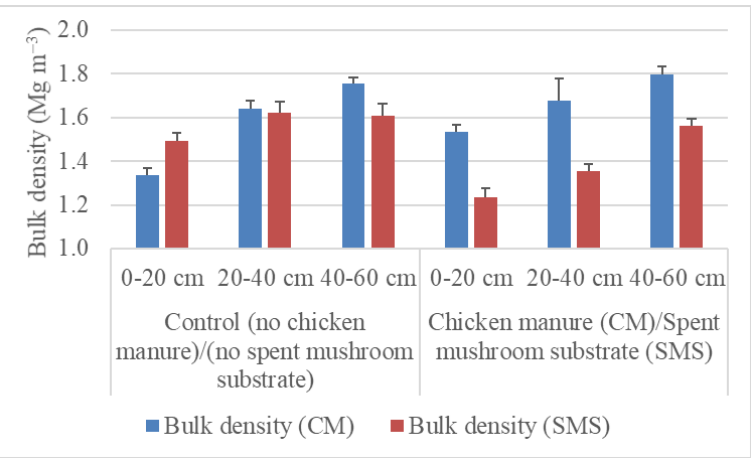
Figure 5. Bulk density at depths of 0–20, 20–40, and 40–60 cm. The bars represent standard devia-